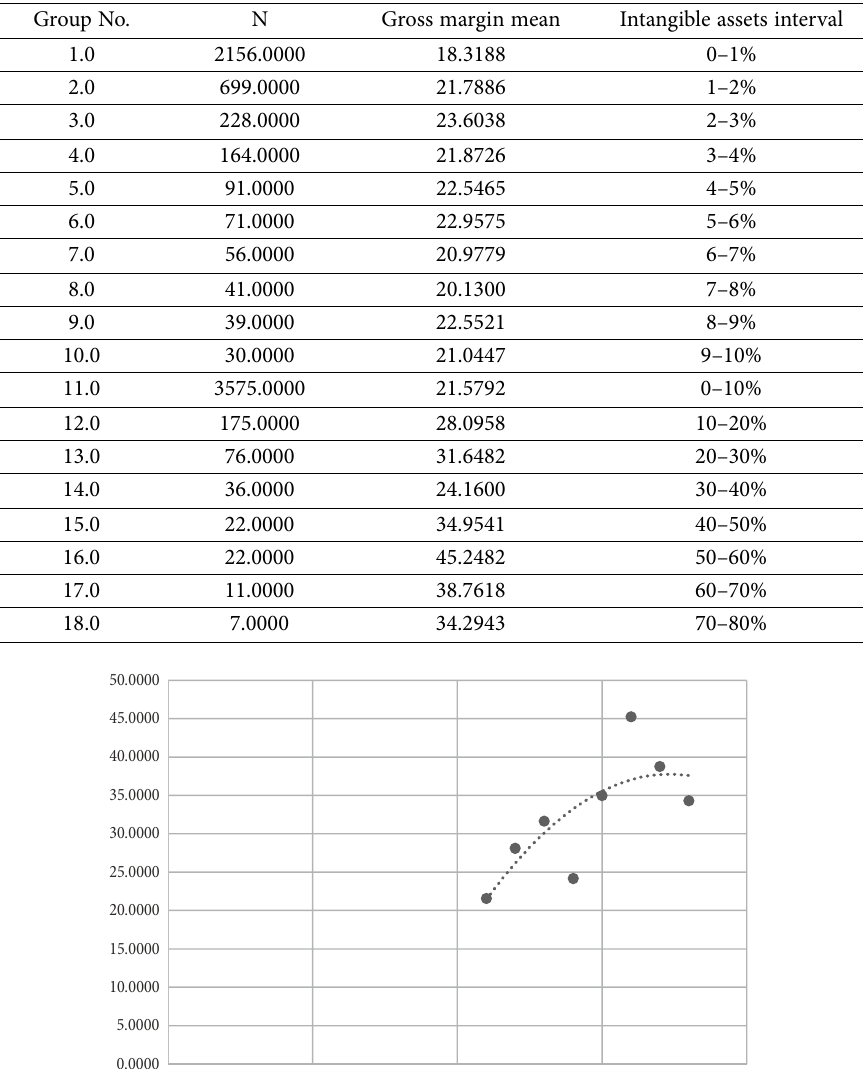
Table 3A. Gross margin mean analysis: average gross margin based on intangible assets intervals Group No.